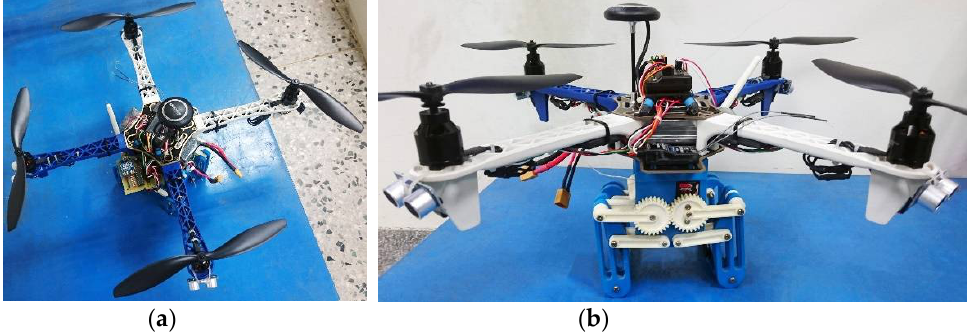
Figure 12. The UAV aircraft: ( a ) top view and ( b ) front view.